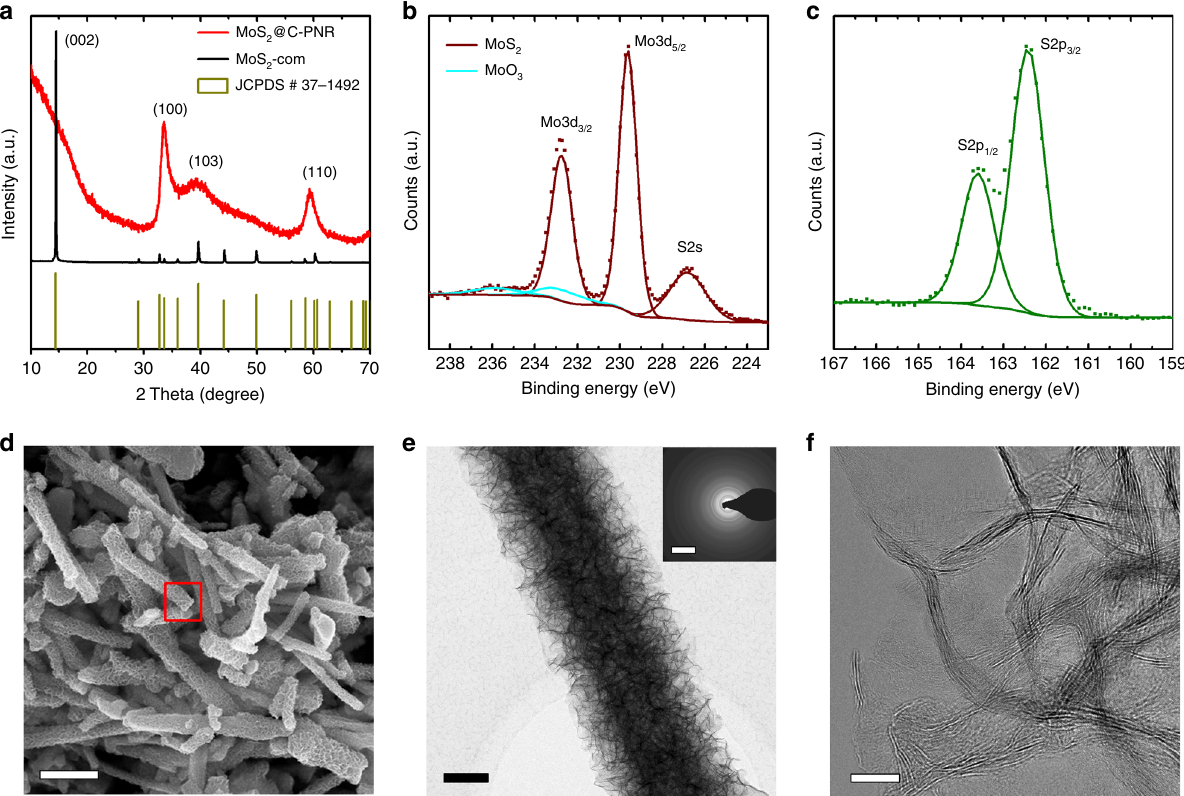
Fig. 1 Structural characterization of MoS 2 @C-PNR. a XRD patterns (red) and comparison with MoS 2 -com (black) and standard 2H-MoS 2 (dark yellow, JCPDS #37-1492); b , c XPS Mo 3 d and S 2 p spectra; d representative SEM image (scale bar = 2 µ m), the EDX spectrum shown in Supplementary Fig. 2 were recorded in the area of the red square; e TEM image (scale bar = 200 nm) with SEAD pattern insert (scale bar = 10 1/nm) and f HRTEM image